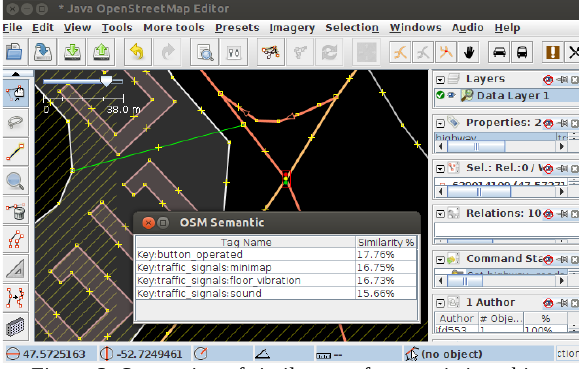
Figure 3. Suggestion of similar tags for an existing object